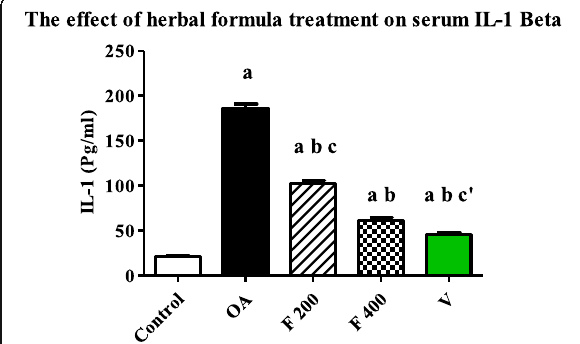
Fig. 3 Serum level of IL-1 Beta (Pg/ml) in the experimental groups. Herbal formula treatment decreased serum level of IL-1 Beta in the osteoarthritic rats at the end of 1 month treatment; C = control; OA = osteoarthritis; F 200 = herbal formula 200 mg/kg; F 400 = herbal formula 400 mg/kg; V = Voltaren. Results were expressed as mean ± SEM and analyzed using one-way ANOVA followed by Bonferroni ’ s post hoc test, a = Significant from control at P <0.0001, b = Significant from OA at P < 0.0001, c = Significant from F 400 at P < 0.0001, c ’ = Significant from F 400 at P <